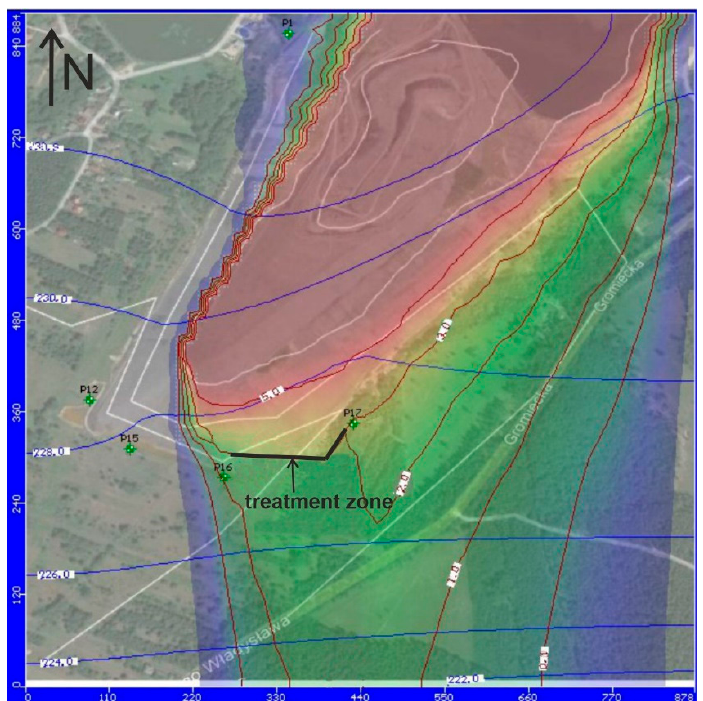
Figure 8. Results of modeling groundwater treatment using nZVI suspension for Q4 2010. P1, P12, P15, P16, P17—piezometers; numbers in the two blue axes—distance in meters; blue numbers—the height of the groundwater table; red numbers—concentration of Zn(II).